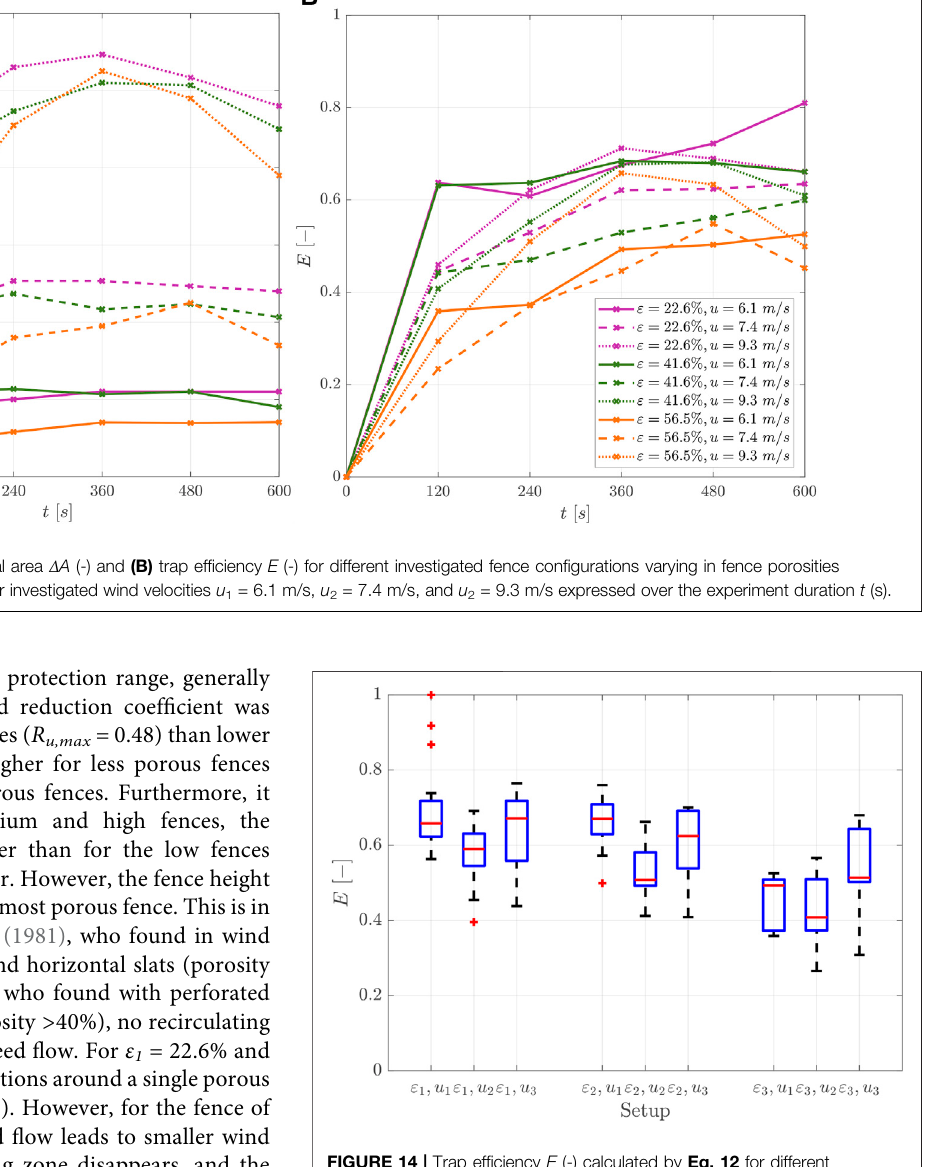
FIGURE 14 | Trap ef fi ciency E (-) calculated by Eq. 12 for different investigated fence con fi gurations varying in fence porosity ε 1 = 22.6%, ε ε 2 = 41.6%, and 3 = 56.5% for investigated wind velocities u 1 = 6.1 m/s, u 2 =7.4 m/s, and u 3 = 9.3 m/sover the whole measuring time t =600